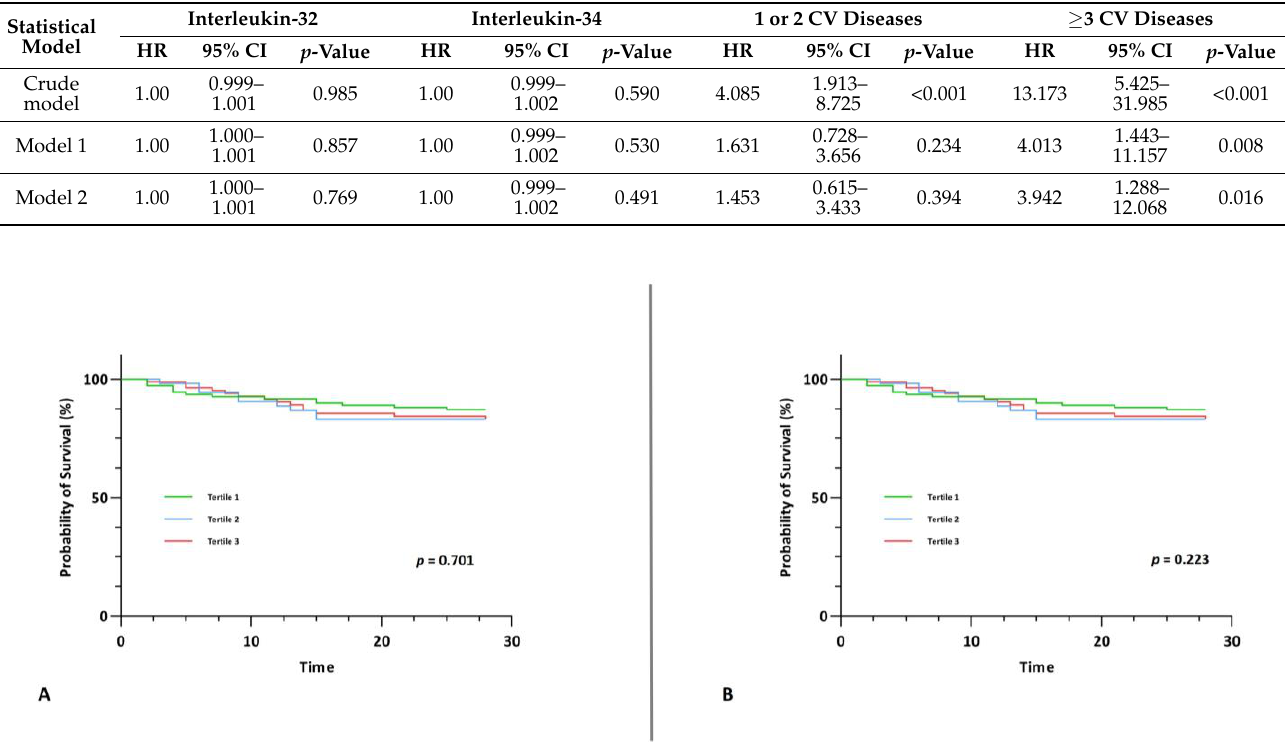
Table 4. Association of interleukin-32, interleukin-34 and CV disease with the primary endpoint. The crude model only included the biomarker in question; Model 1 was adjusted for age and gender; Model 2 was adjusted for Model 1 and arterial hypertension, diabetes mellitus, chronic kidney disease and chronic pulmonary disease.